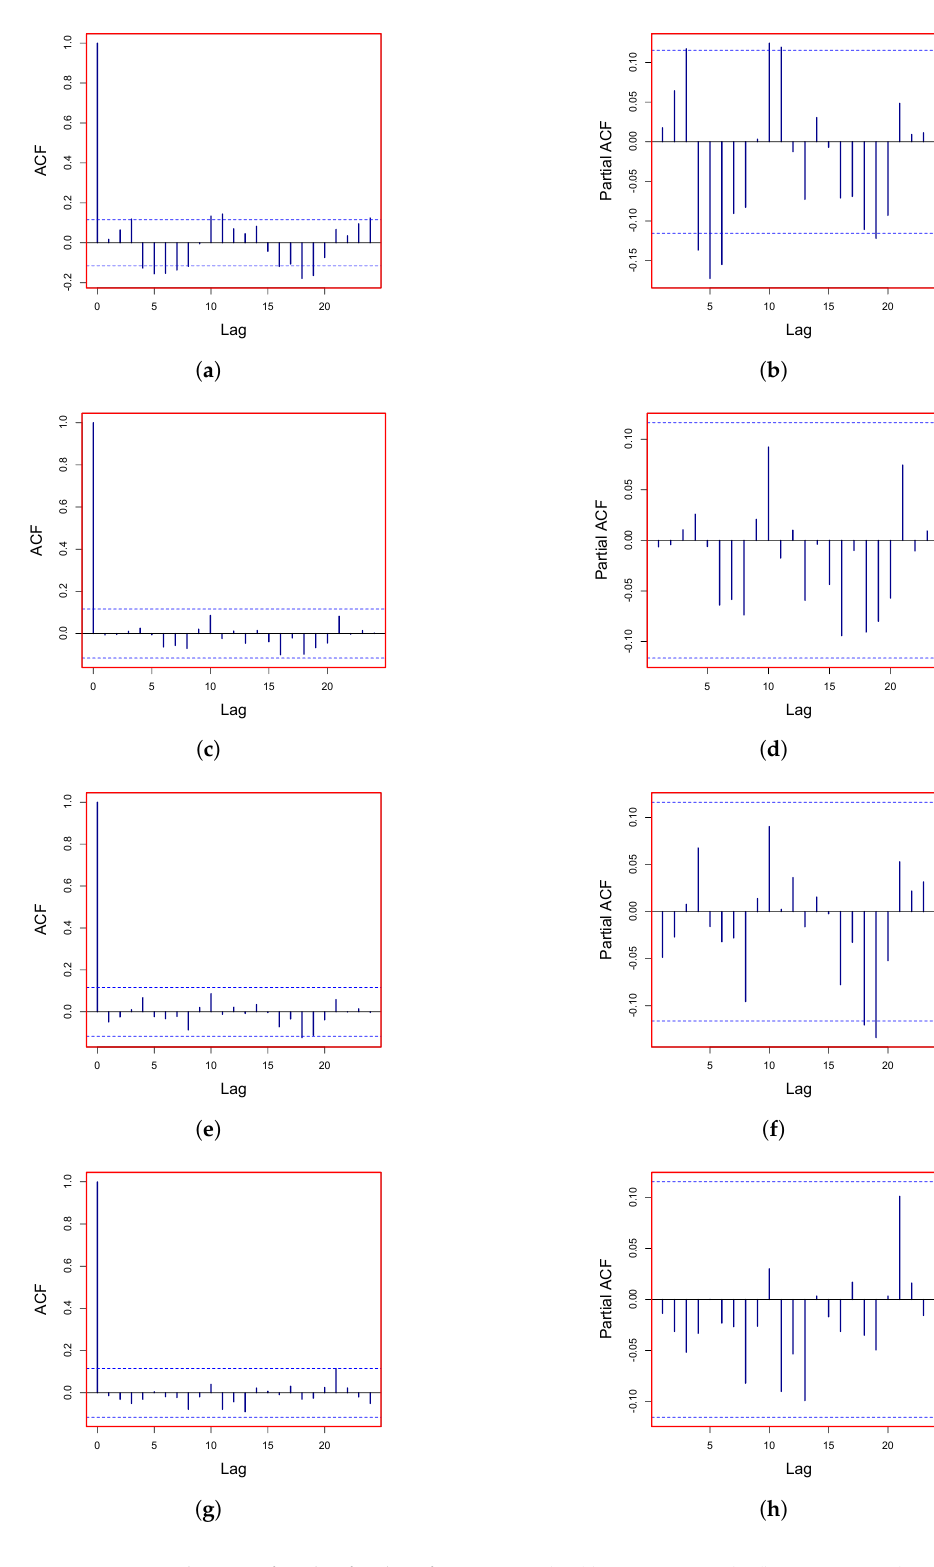
Figure 7. ACF and PACF for the final (cid:101) t for NP-AR ( a , b ), NP-NPAR ( c , d ), NP-STAR ( e , f ) and NP-ARMA ( g , h